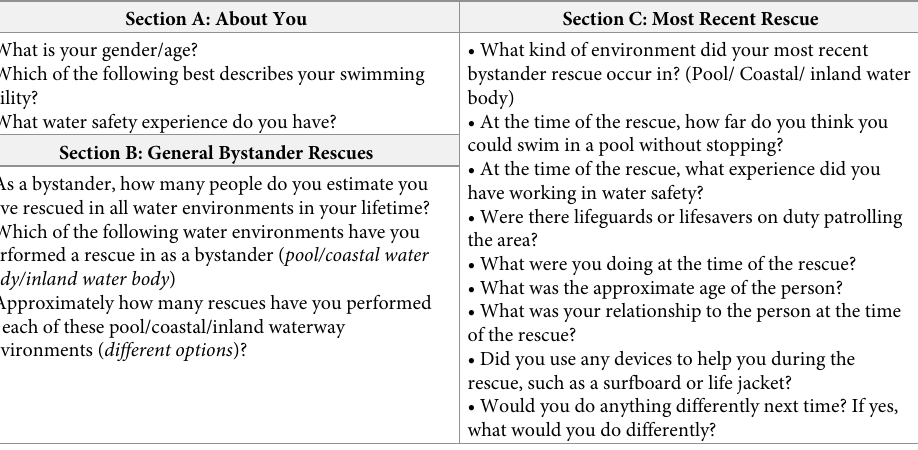
Table 1. Examples of questions asked in the ‘Citizen Lifesavers Survey’. Note that some questions are slightly modi- fied from versions in the actual survey (S1